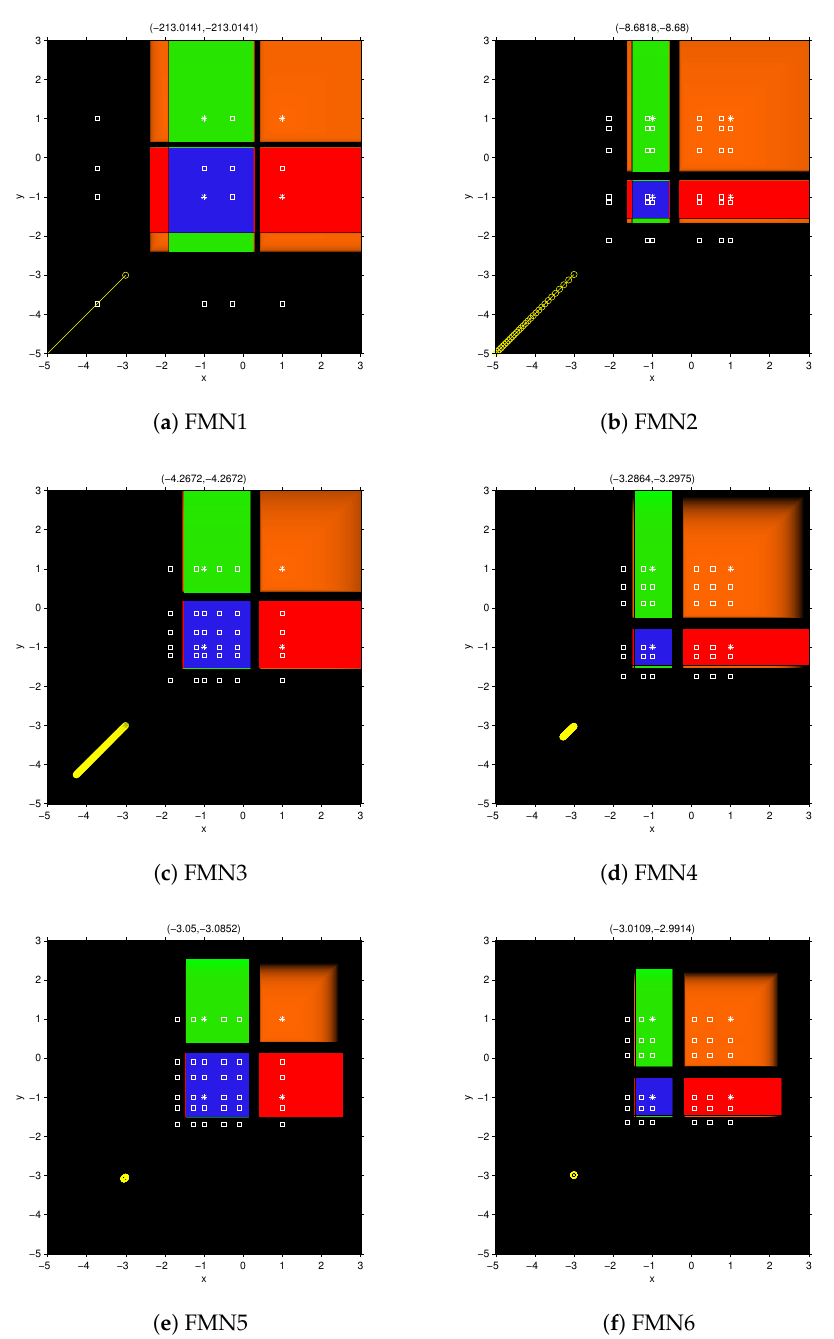
Figure 1. Dynamical plane for FMN m , m = 1,2, . . . ,6 on q ( x ) . Green, orange, red and blue areas are the basins of attraction of the roots of q ( x ) (marked as white stars); black area denotes divergence and white squares are free critical